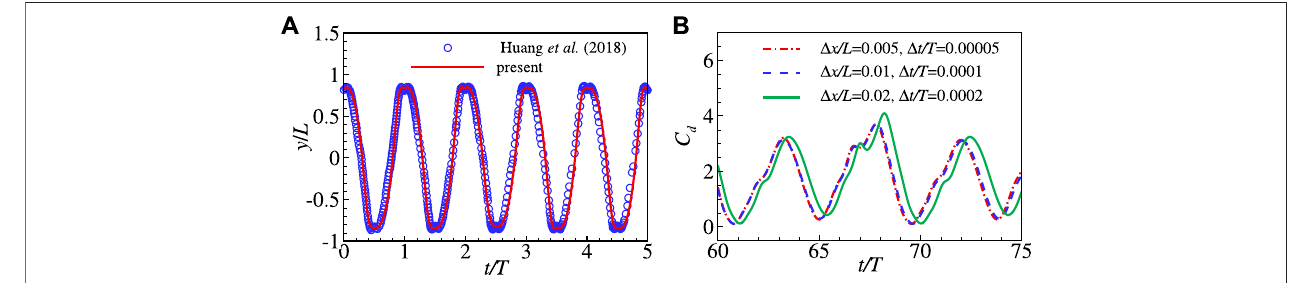
Frontiers in Physics |